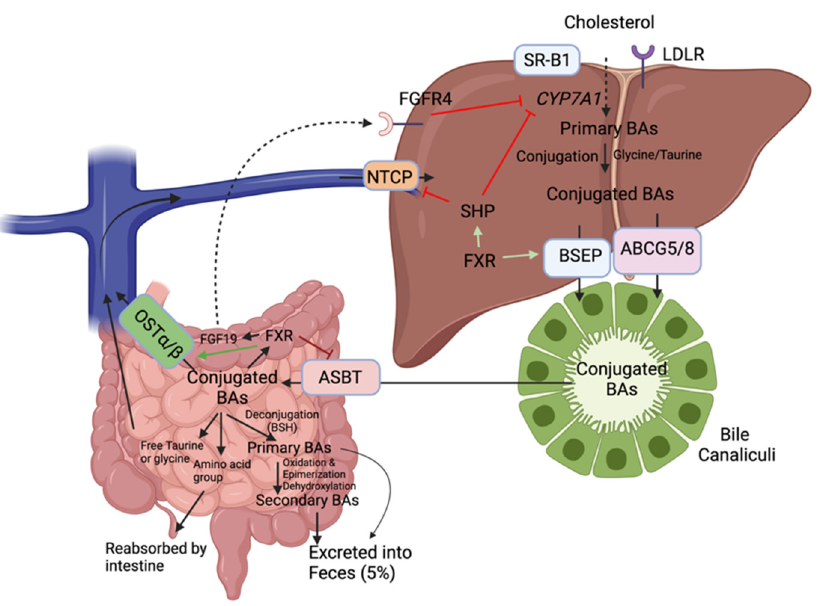
Figure 4. Enterohepatic recirculation of bile acids via reverse cholesterol transport. In the liver, cholesterol is metabolized to BAs by hepatic cytochromes, notably 90% of the time by the rate-limiting enzyme cholesterol 7 α -hydroxylase (CYP7A1). When BAs are conjugated, they are actively transported into bile via the bile salt export pump (BSEP) or via ABCG5/8. In the small intestine, certain gut microbes contain an enzyme known as bile salt hydrolase (BSH) capable of deconjugating (i.e., remove glycine or taurine conjugates) BAs preventing their reuptake by the ASBT transporter BAs: Bile acids; apical sodium-dependent bile acid transporter: ASBT; organic solute transporters: OST α / β ; nuclear farnesoid X receptor: FXR; bile salt export pump: BSEP; Na+/taurochlorate cotransporting polypeptide: NTCP; fibroblast growth factor receptor 4 (FGFR4).